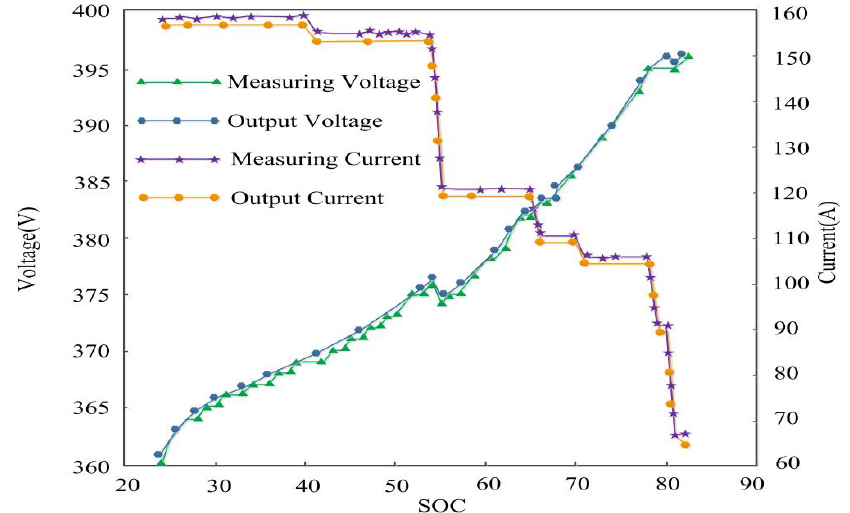
Figure 12. The curve diagram of the measured voltage, output voltage, and measured current output current of lithium iron phosphate battery during the charging process of the EV in the normal state. voltage and the output voltage are increasing. However, as the SOC increases, both the the overall value of the output voltage is slightly higher than the measured voltage,